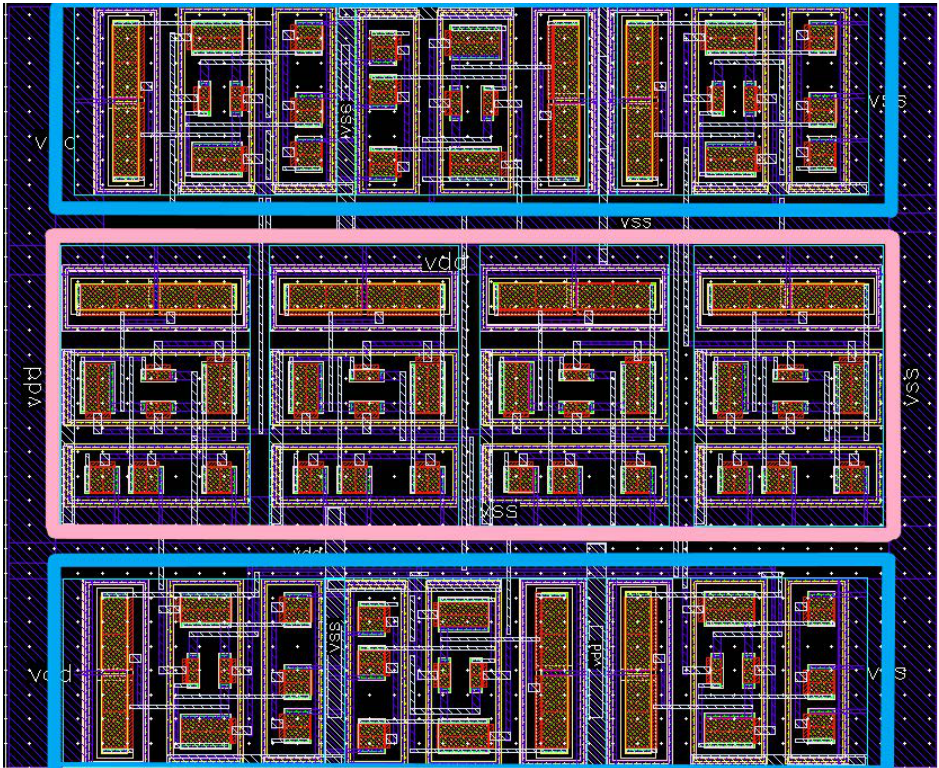
Figure 6. Layout design of the OTA-C structure in Figure 4 (the pink framed part corresponds to the integration stage, while the blue framed part represents the summation